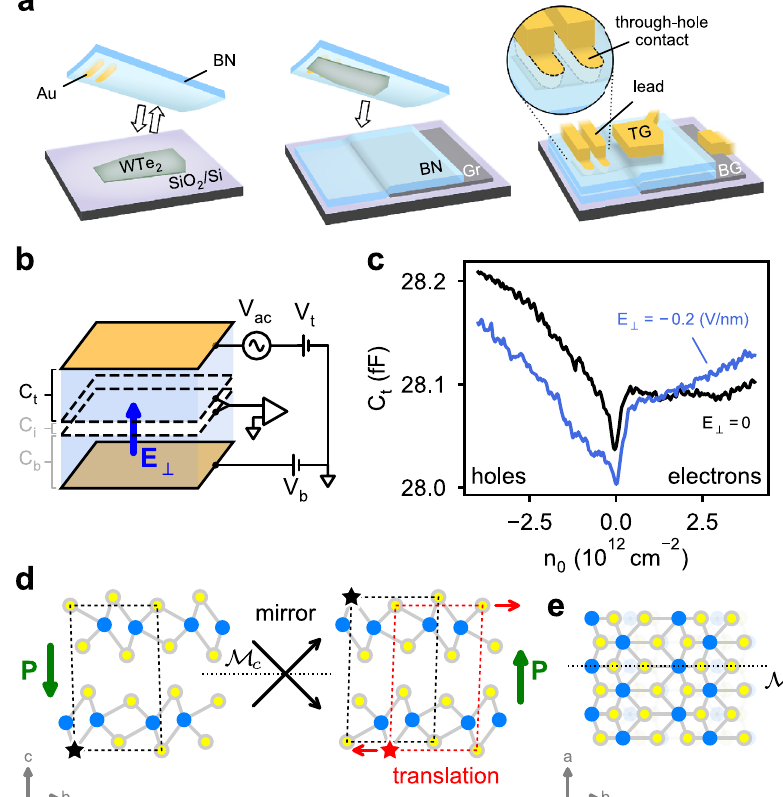
Fig. 1 Fabrication and measurement of the bilayer capacitance device. a Schematic of our lithography-free encapsulation and contact method, using a boron nitride (BN) crystal previously prepared with through-hole Au contacts to pick up and transfer WTe 2 on to another BN dielectric layer with a graphite bottom gate below. Top gate and leads to the through-hole contacts and bottom gate are patterned after fully encapsulating the WTe 2 . b Measurement schematic showing the measurable capacitances: C t , between the top gate and WTe 2 , and C b , between the bottom gate and WTe 2 . C i is the interlayer capacitance across the bilayer. c Measured top capacitance, C t , as a function of carrier density, n 0 , at zero and fi nite electric fi eld, E ⊥ . d Side-view structure of bilayer WTe 2 in two stable con fi gurations, each showing the net polarization state along c -axis ( P ). The two states are related equivalently by a mirror operation along the c -axis ( M c ) or by lateral translation between the layers along the b -axis of 0.72 Å 18,19 , or ~11% of the unit cell. The ⋆ symbol labels a Te atom before and after the mirror operation (black) and translation (red) as a visual guide. The mirror/translation equivalence allows a subtle shift between the layers to switch the structure between polarization states. e Top-view structure showing the only invariant symmetry of the crystal, mirror re fl ection along the a -axis ( M a